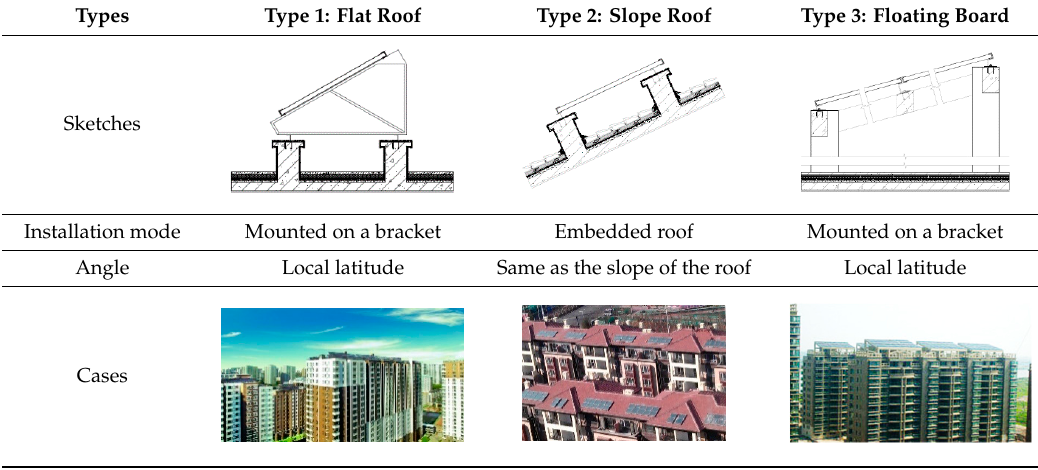
Table 4 Solar collectors installation modes on roofs.